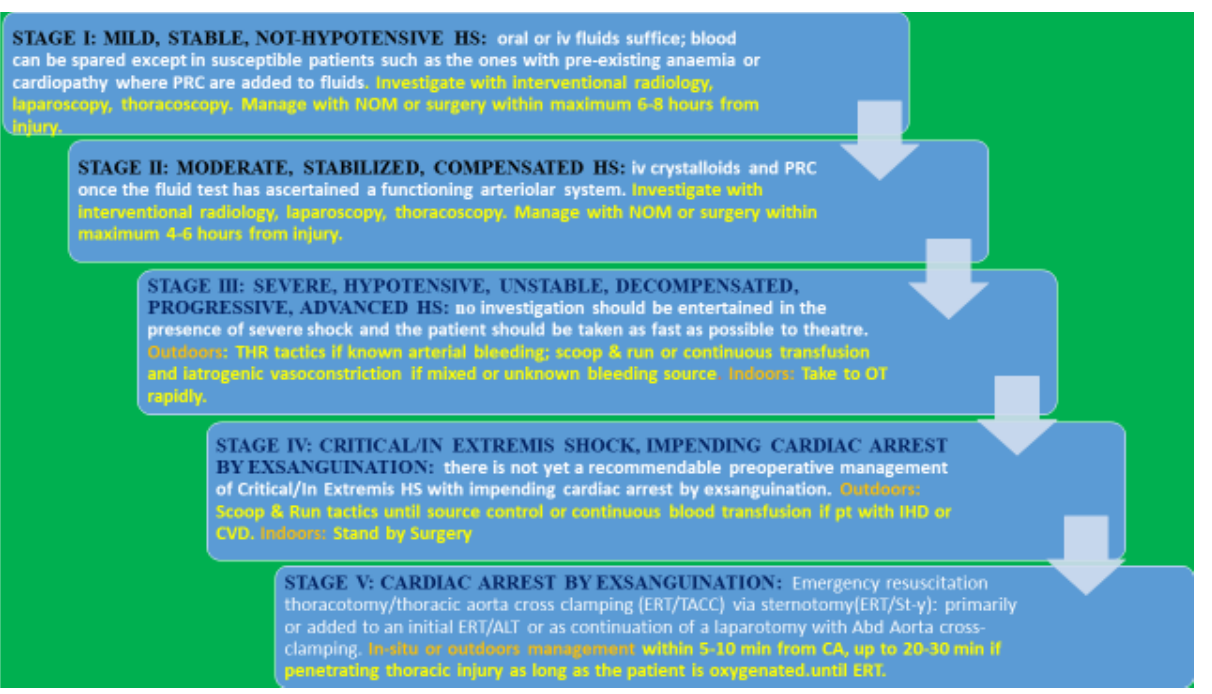
Figure 2. Therapeutical classification of hemorrhagic shock. NOM = non-operative management; PRC = packed red cells; OT = operating theatre; CA = cardiac; ARREST St-Y = sternotomy; TACC = thoracic aorta cross-clamping; HR = hypotensive resuscitation; ERT = emergency resuscitative thoracotomy; ALT = anterolateral thoracotomy; THR = titrated hypotensive resuscitation. At present, only in vivo peripheral microcirculation visualization and continuous cardiac output (CO) monitoring through trans-thoracic echocardiography (TTE) can add